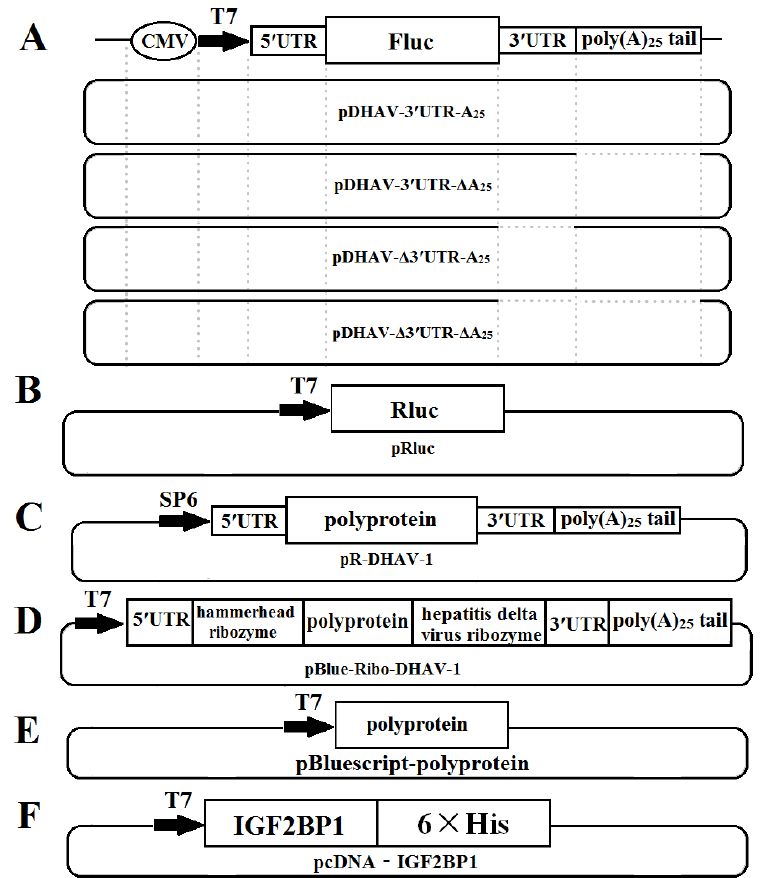
Figure 1. Construction schematic of the plasmids used in this study: ( A ) Construction